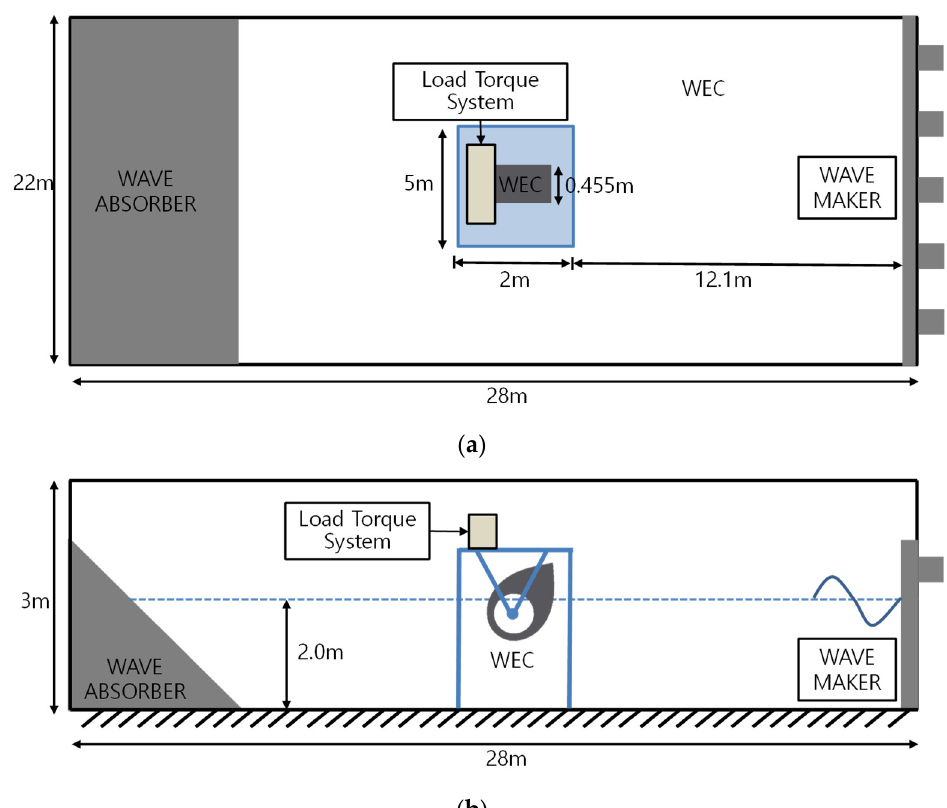
Figure 1. Sketch of experimental wave tank. ( a ) Plan view and ( b ) side view. Table 1. Specifications of an asymmetric WEC (1/11 scale).